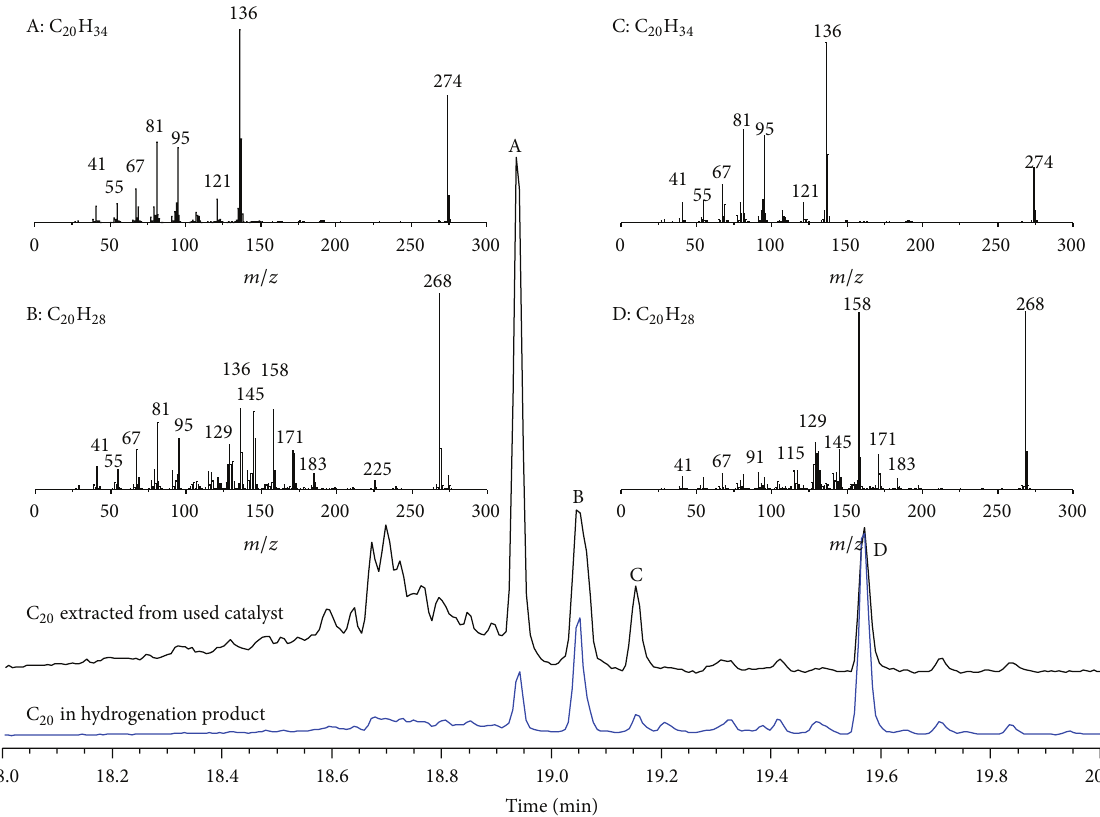
Figure 8: GC-MS spectra of C 20 components in product and used